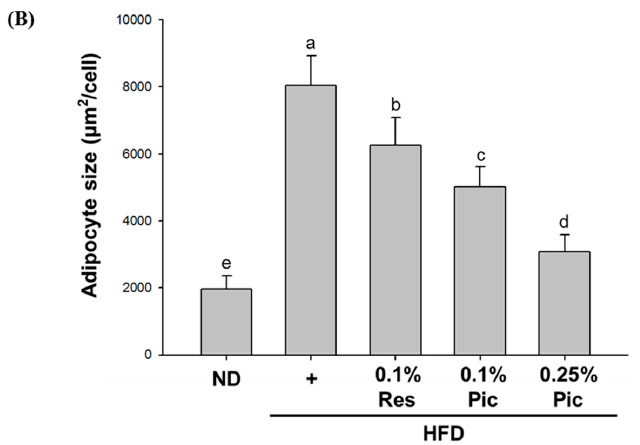
Figure 3. Effect of piceatannol supplementation on adipocyte size in HFD-fed C57BL/6 mice. ( A ) Histology of perigonadal adipose tissues by H & E staining (100× magnification); ( B ) The adipocyte size was quantified microscopically from representative sections ( n = 15). The values with different letters are significantly different ( p < 0.05) as determined by Duncan’s multiple range test.